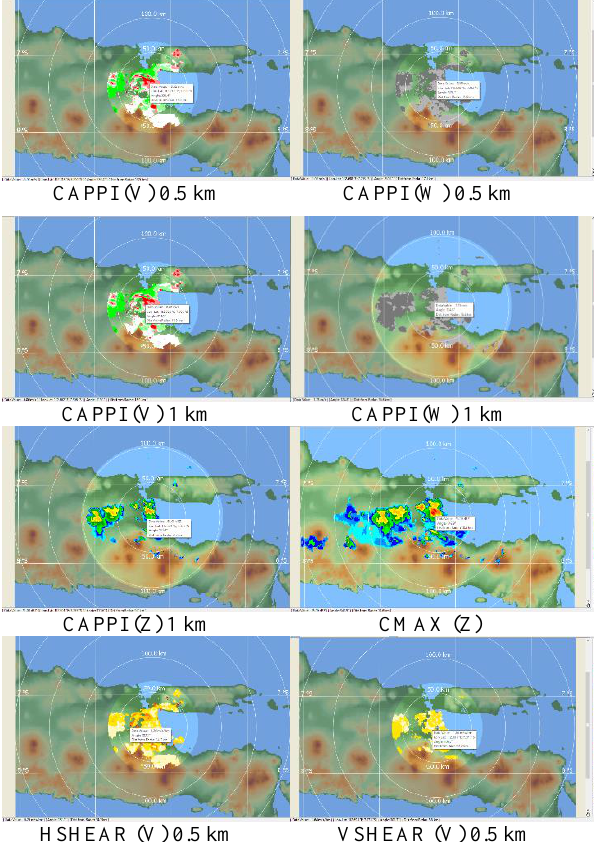
Figure 7. Radar product at whirl wind occurence